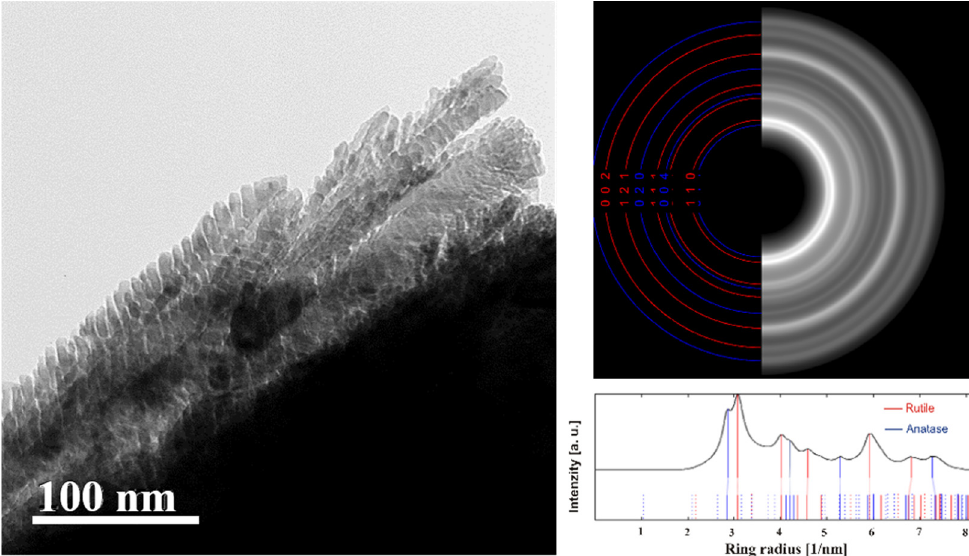
Figure 4. TEM micrograph of TiO 2 nanocrystals deposited onto the TEM grid directly by plasma jet ( left ). SAED pattern ( right ); blue and red circles indicate anatase and rutile, respectively. DCDF TEM